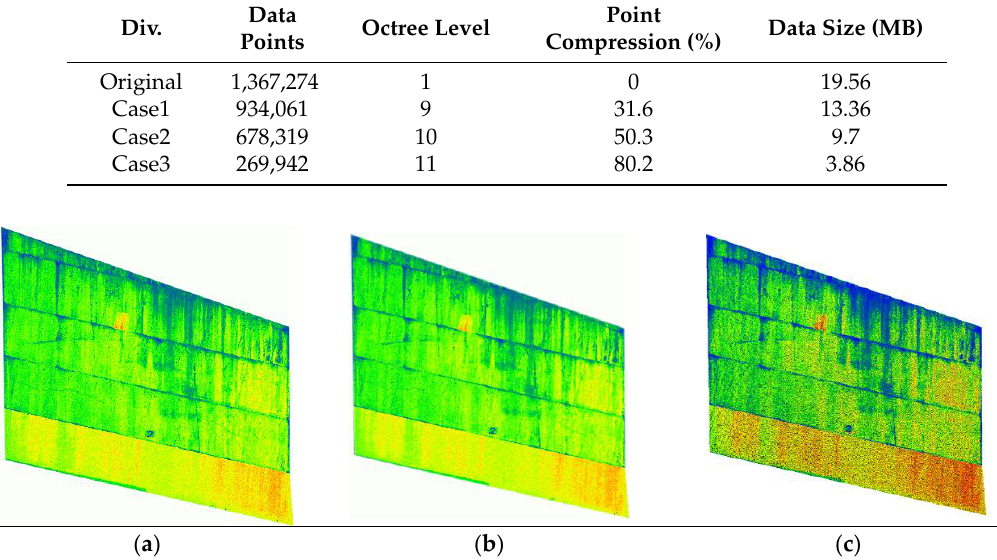
Table 5. The number of compressed points and data size by octree structure.